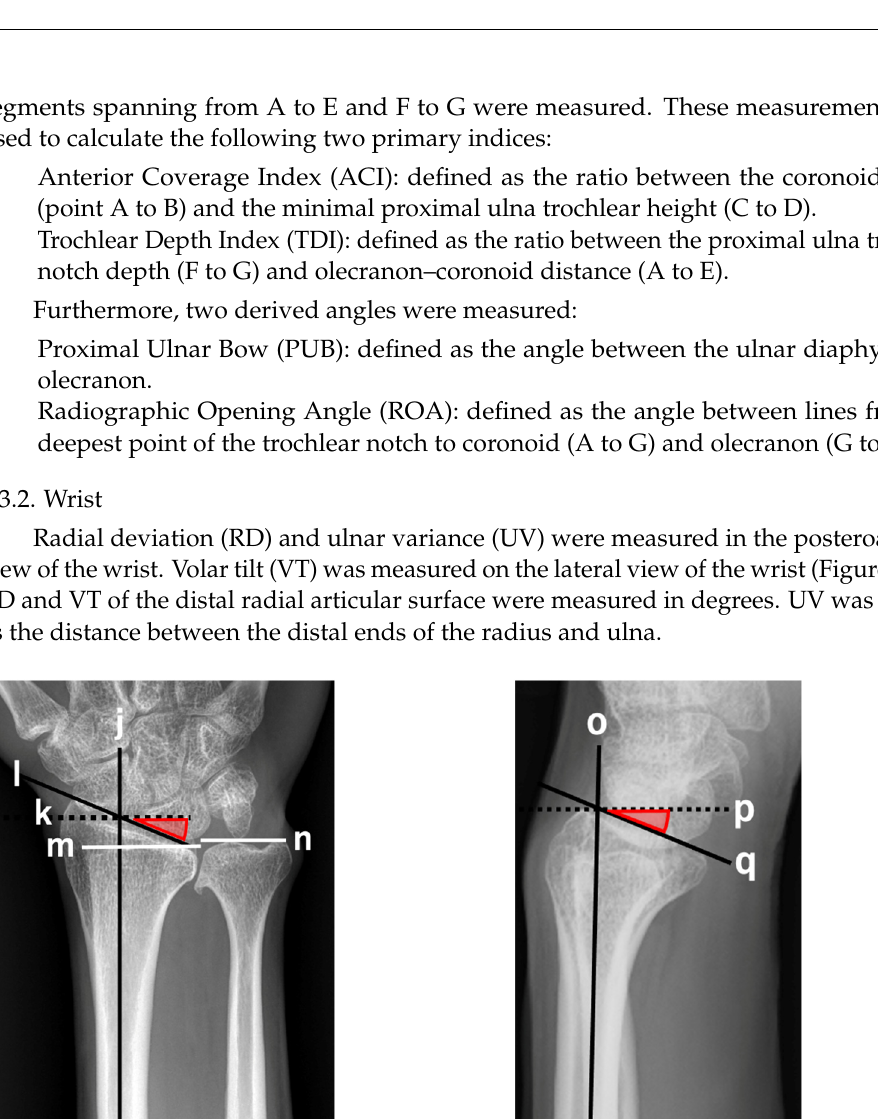
Figure 2. Measurement in the wrist joint. j: long axis of the radius in posteroanterior view, k: line perpendicular to long axis of radius in posteroanterior view, l: tilt of the distal end of the radius on posteroanterior radiograph, m: distal end of the radius, n: distal end of the ulna, o: long axis of the radius in lateral view, p: line perpendicular to long axis of the radius in lateral view, q: tilt of the distal end of the radius on lateral radiograph. ( A ) Radial deviation (RD) is determined by lines k and l. Ulnar Variance (UV) is the sum of lines m and n. ( B ) Volar tilt (VT) is determined by lines p and q.